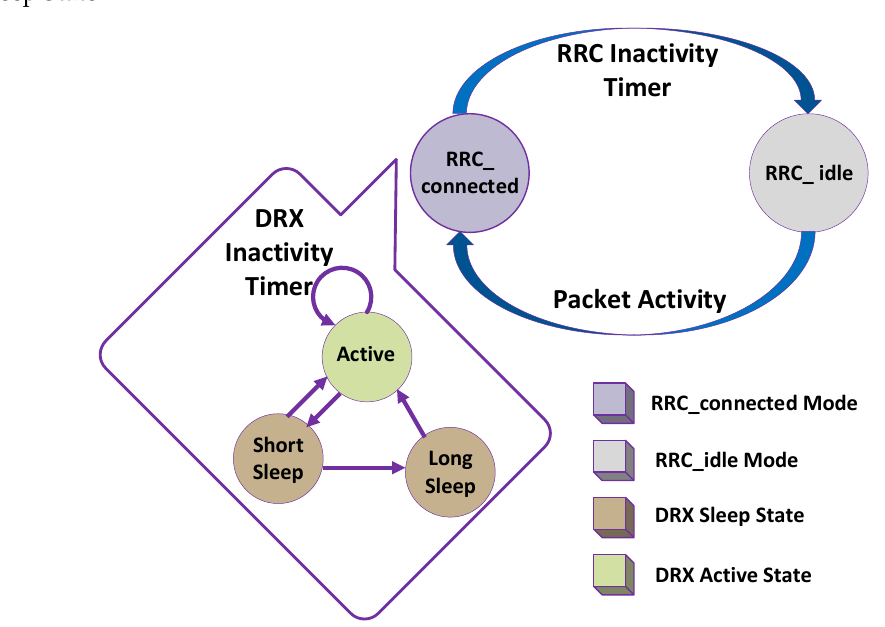
Figure 1. LTE-DRX in RRC_connected